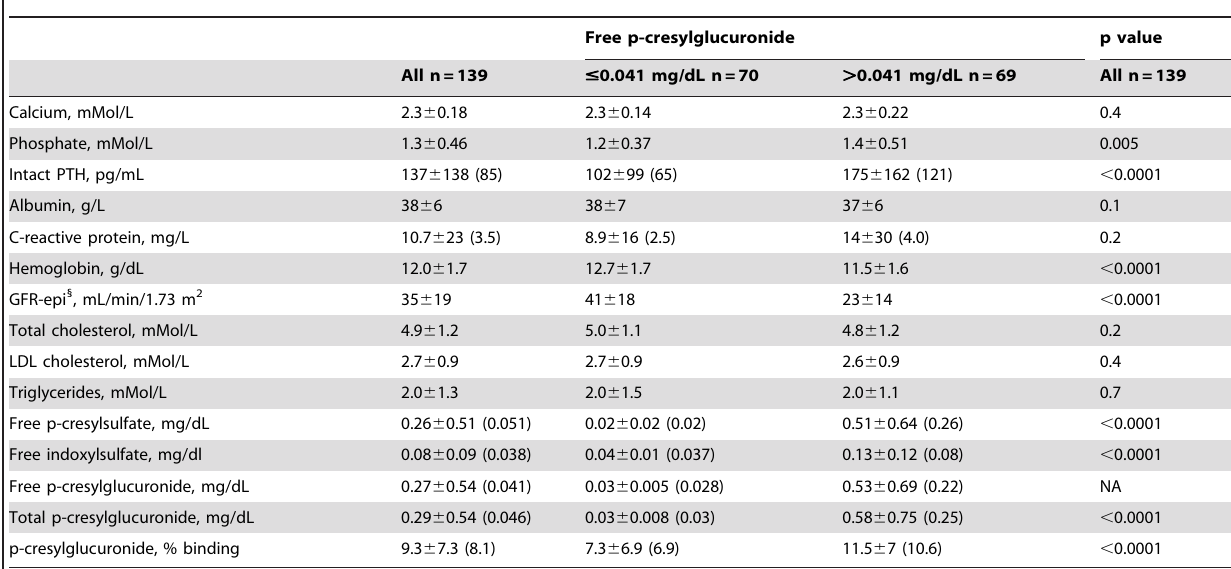
Table 2 . Biochemical characteristics of the study